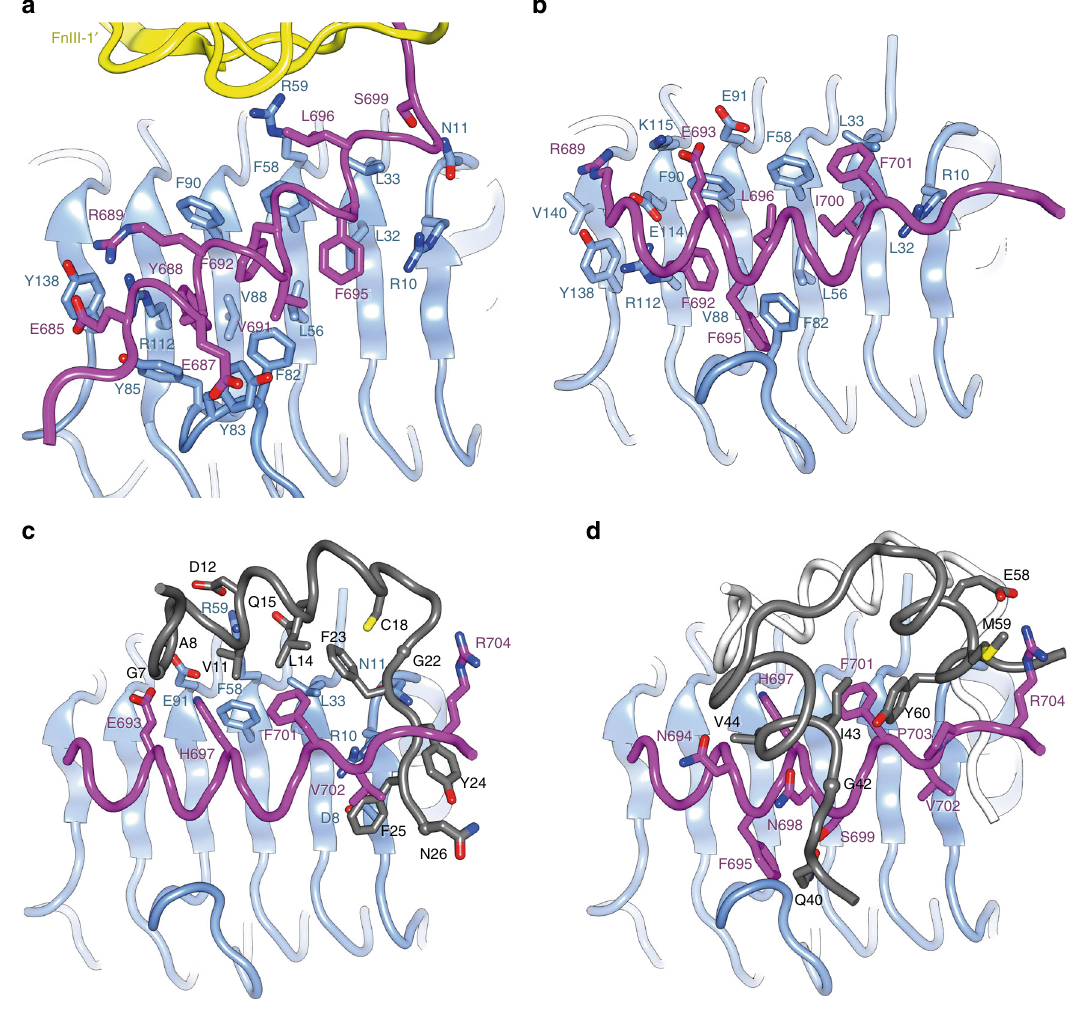
Fig. 6 Dissection of the interaction of IGF-I with binding site 1 of IGF-1R. a Conformation of L1- β 2 (light blue) and α CT ΄ (magenta) in the apo IGF-1R Δβ structure, compared with b , its conformation in the IGF-I liganded IGF-1R Δβ structure. c Interaction between B domain of IGF-I (black) and the IGF-1R site 1 elements of L1- β 2 (light blue) and α CT ΄ (magenta). The A domain of IGF-I (located in the foreground) is omitted for clarity. d Interaction between A domain of IGF-I (black) and the IGF-1R site 1 element α CT ΄ (magenta); no interaction is observed between the A domain and L1- β 2 (light blue). The IGF-I B domain is in